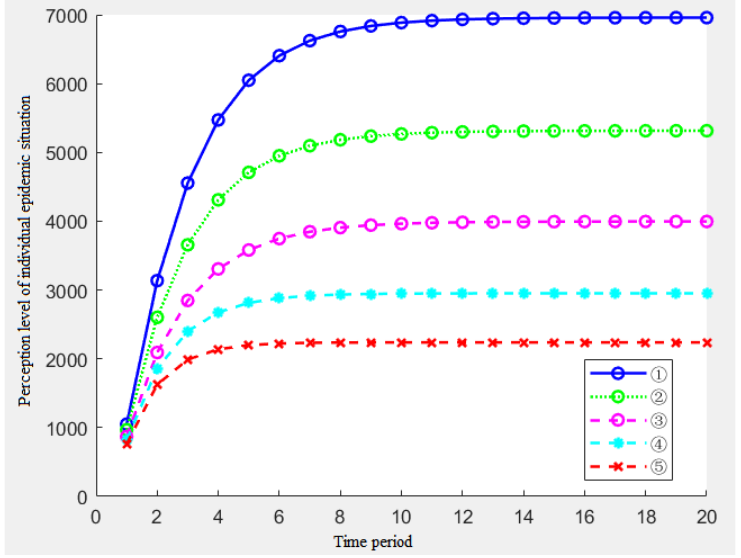
Figure 2. Effects of the five combinations of ρ and k on the individual epidemic perception.